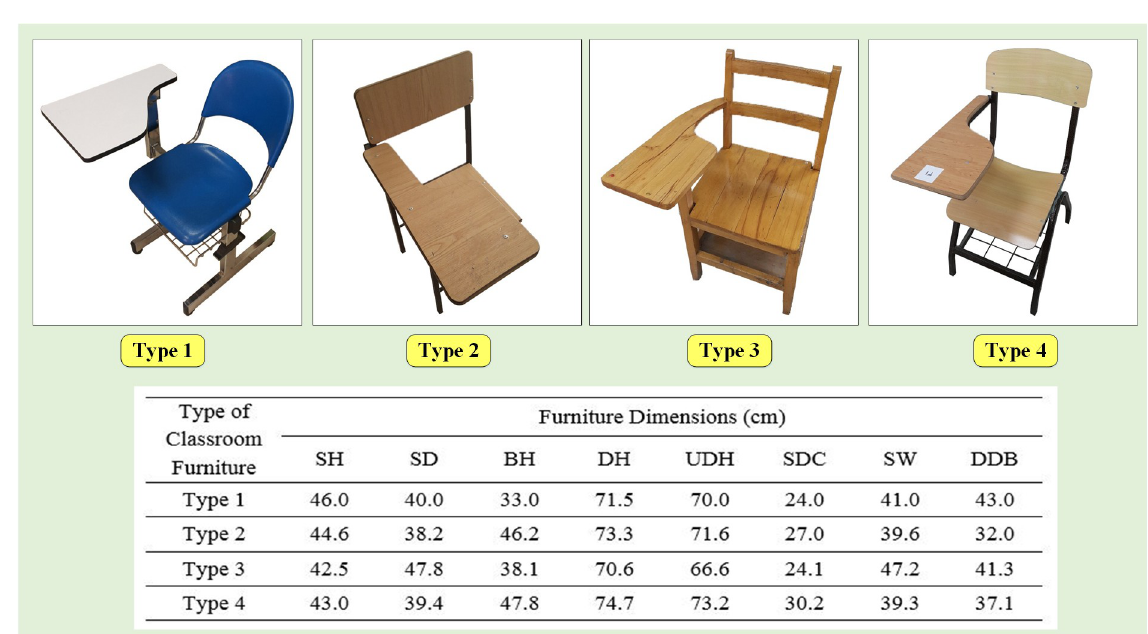
Fig 5. Furniture dimensions results for four type of used chair with attached